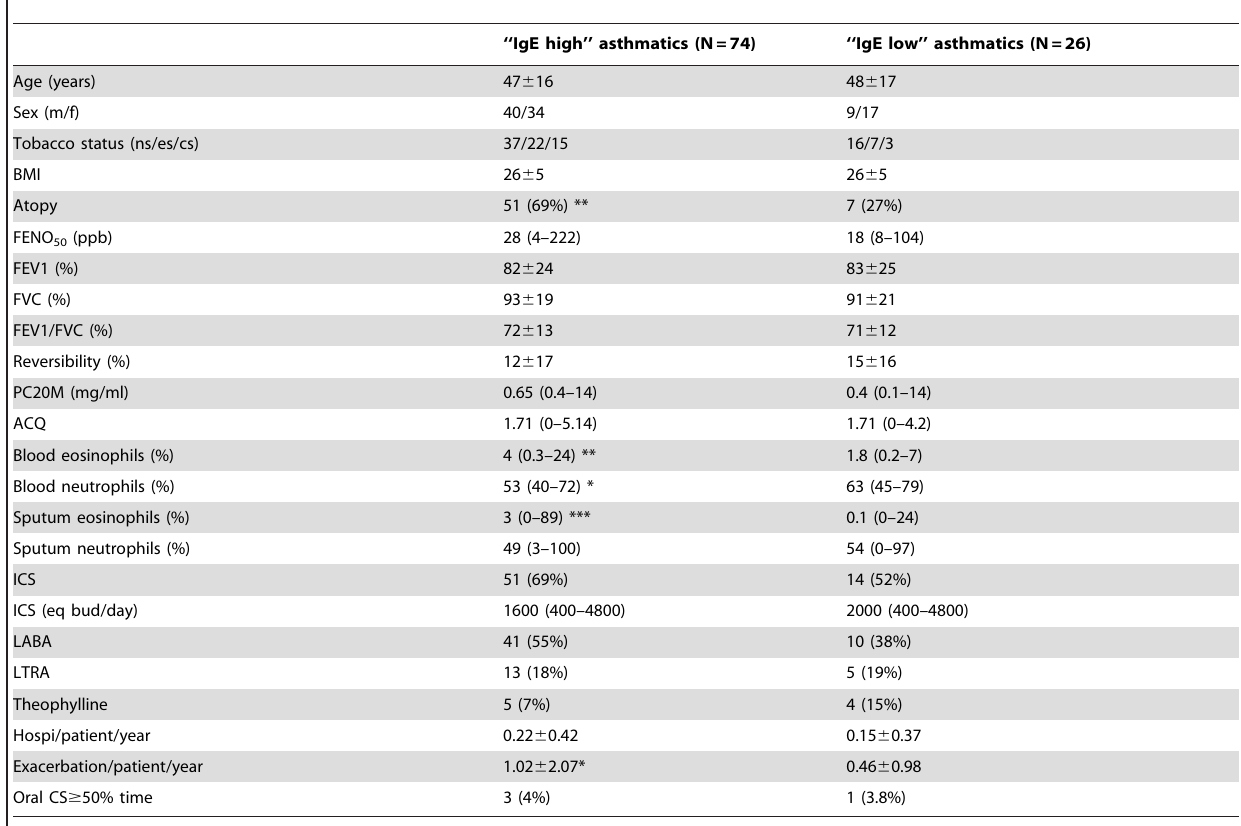
Table 3. Demographic, functional, airway inflammatory and treatment characteristics in ‘‘IgE high’’ vs ‘‘IgE low’’